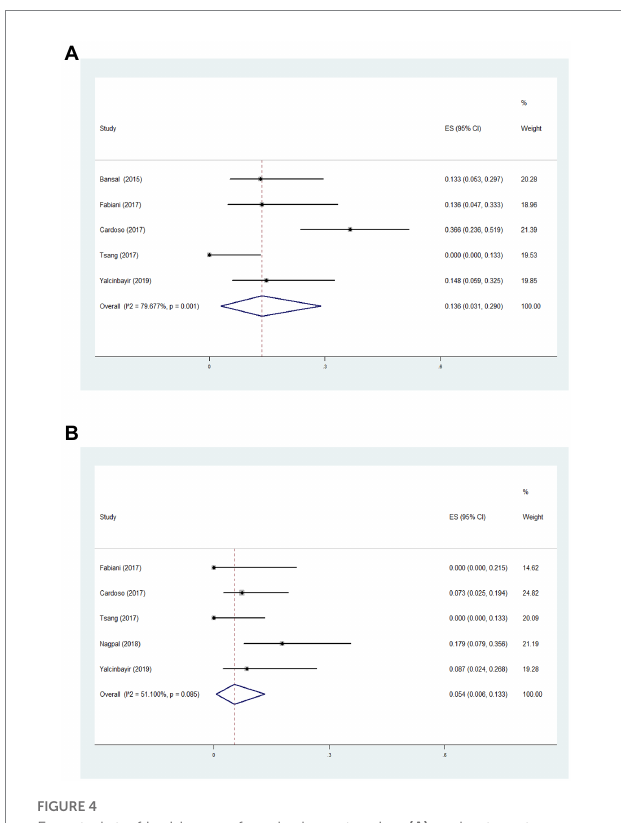
FIGURE 4 Forest plot of incidence of ocular hypertension (A) and cataract formation (B) during